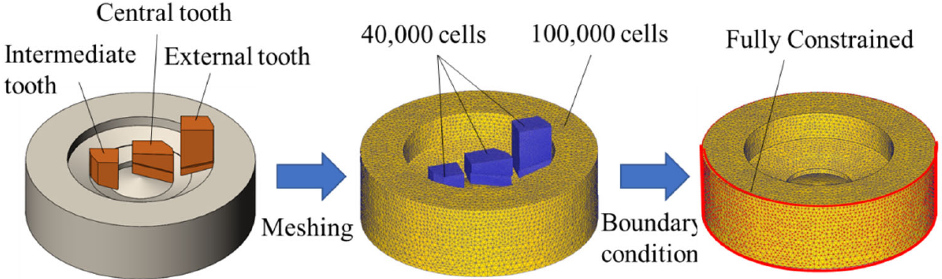
Figure 4. Finite element model of drilling.